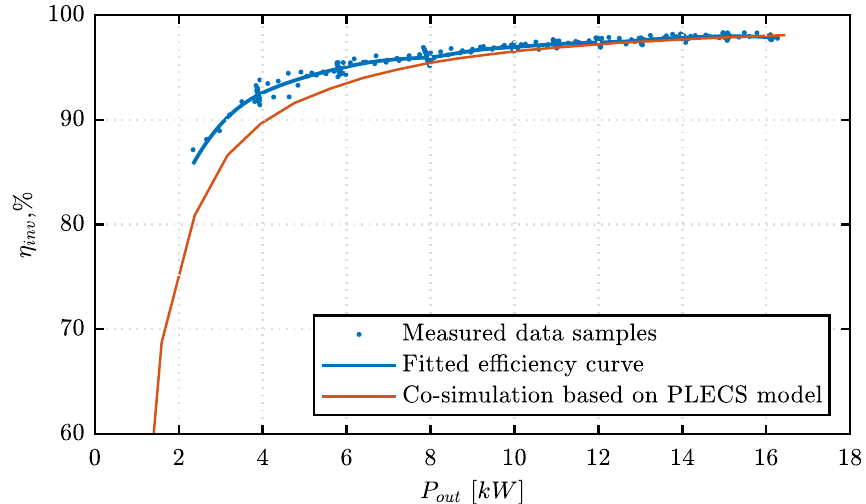
Figure 13. Efficiency curves: experiment and co-simulation